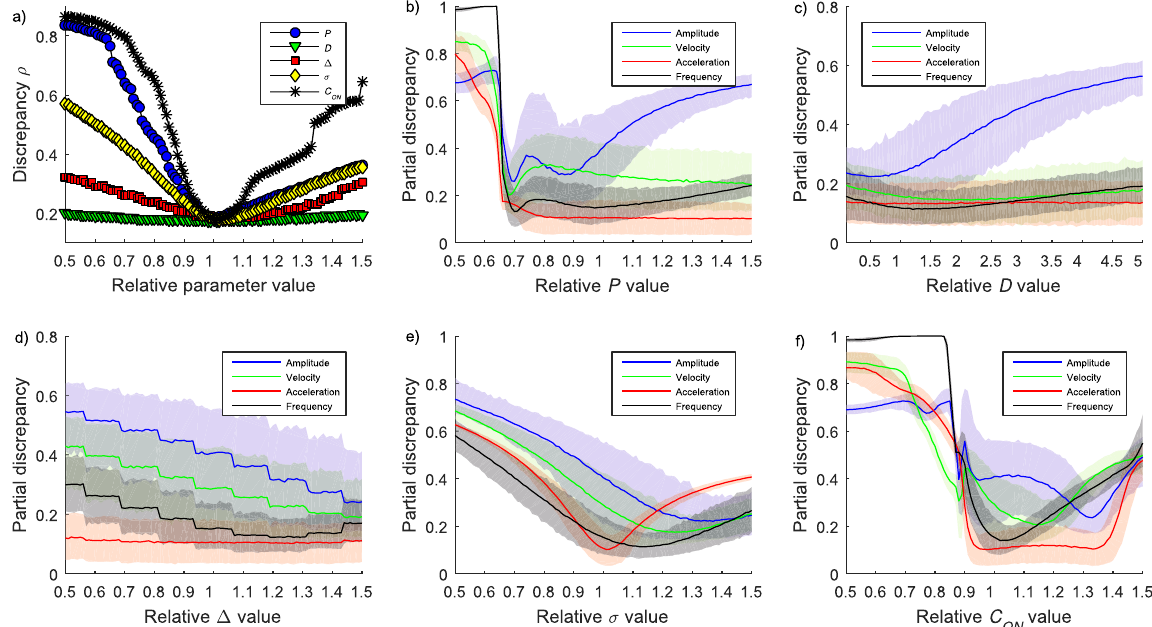
Figure 6. Sensitivity analysis. ( a ) The results are averaged (mean discrepancy and 95% CIs) across the 10 simulated subjects and 100 simulation rounds per subject. All summary statistics are included. ( b – f ) Amplitude-, velocity -, acceleration- histograms, and spectrum used one at the time to form the summary statistics. The results are averaged across 1000 simulation rounds of one representative test subject, the subject presented in the rightmost panel in Fig. 3. and in Fig. 4. The parameters are ( b ) stiffness, P , ( c ) damping, D (please note the wider x-axis scale, from 0.1 to 5), ( d ) time delay, Δ , ( e ) noise, σ , and ( f ) level of control, C ON . Briefly, the steeper the curve the more effectively the summary statistics detects changes in model